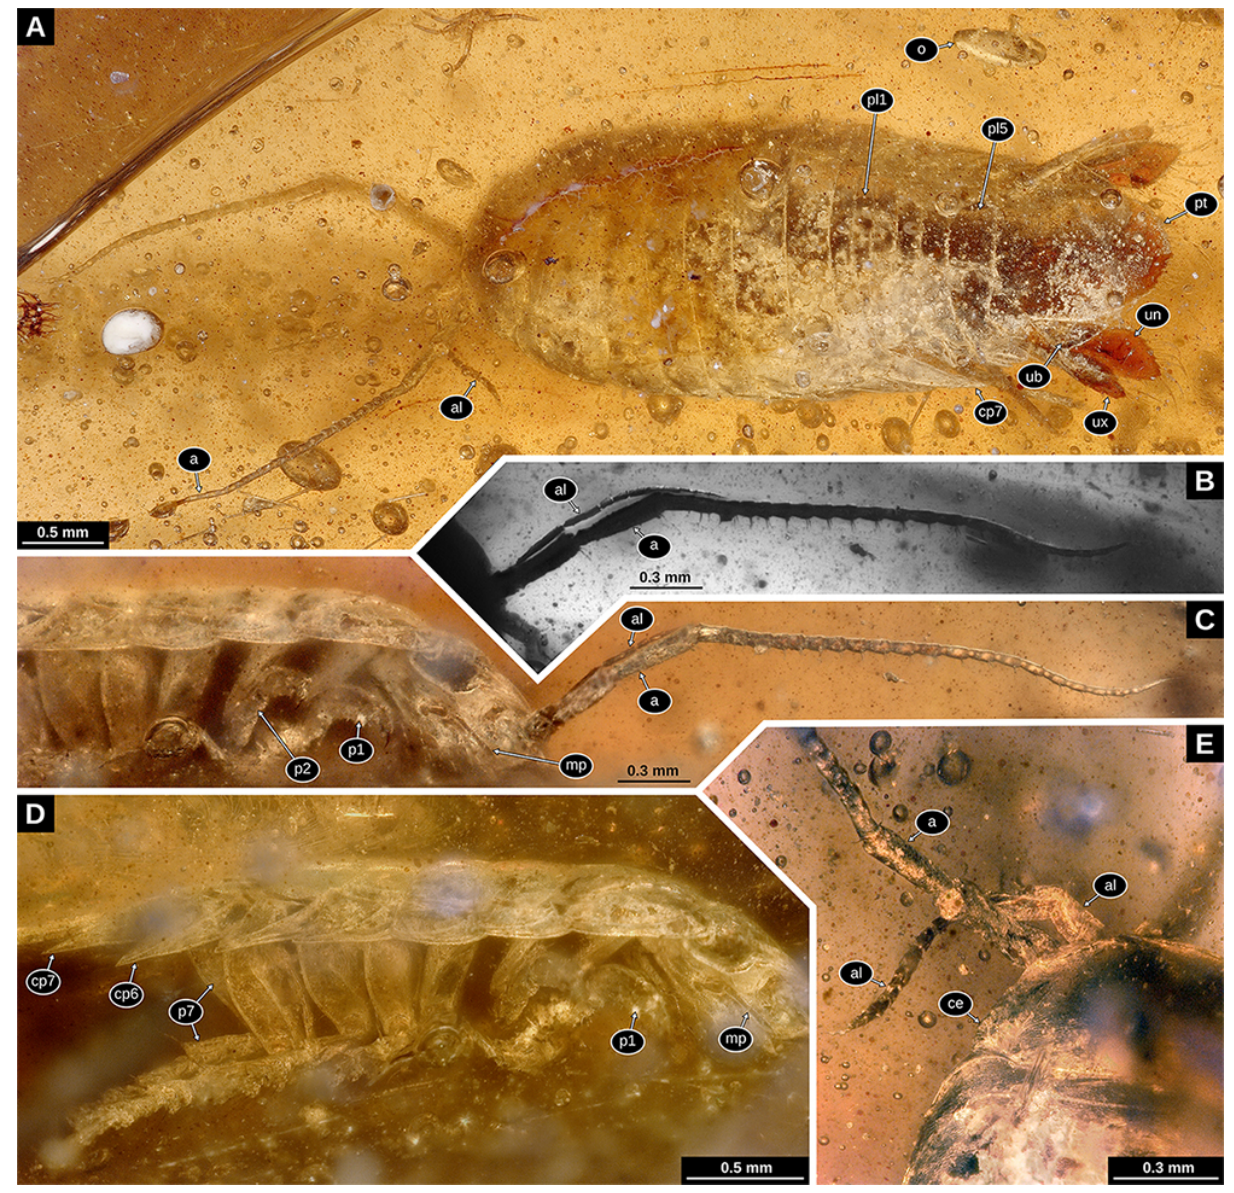
Figure 4. Holotype of Electrolana madelineae sp. nov. (NHMW 2017/0052/0001). A : Habitus in dorsal view, white light microscopy, 200x (VHX). B : anterior head region in ventro-lateral view, transmitted light microscopy, 4x (BZ); C : anterior body region in ventro-lateral view, white light microscopy, 200x (VHX); D : anterior trunk region in ventro-lateral view, white light microscopy, 150x (VHX); E : head region in dorsal view, left body side, white light microscopy, 200x (VHX). a, antenna; al, antennula; ce, compound eye; cp6–7, coxal plate of trunk segment 6–7;mp, mandibular palp; o, seed shrimp (Ostracoda); p1–7, trunk appendages 1–7;